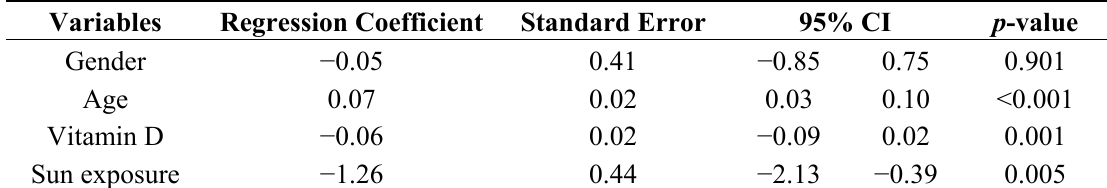
8. Regression coefficients for developing “Severe” MS, according to environmental